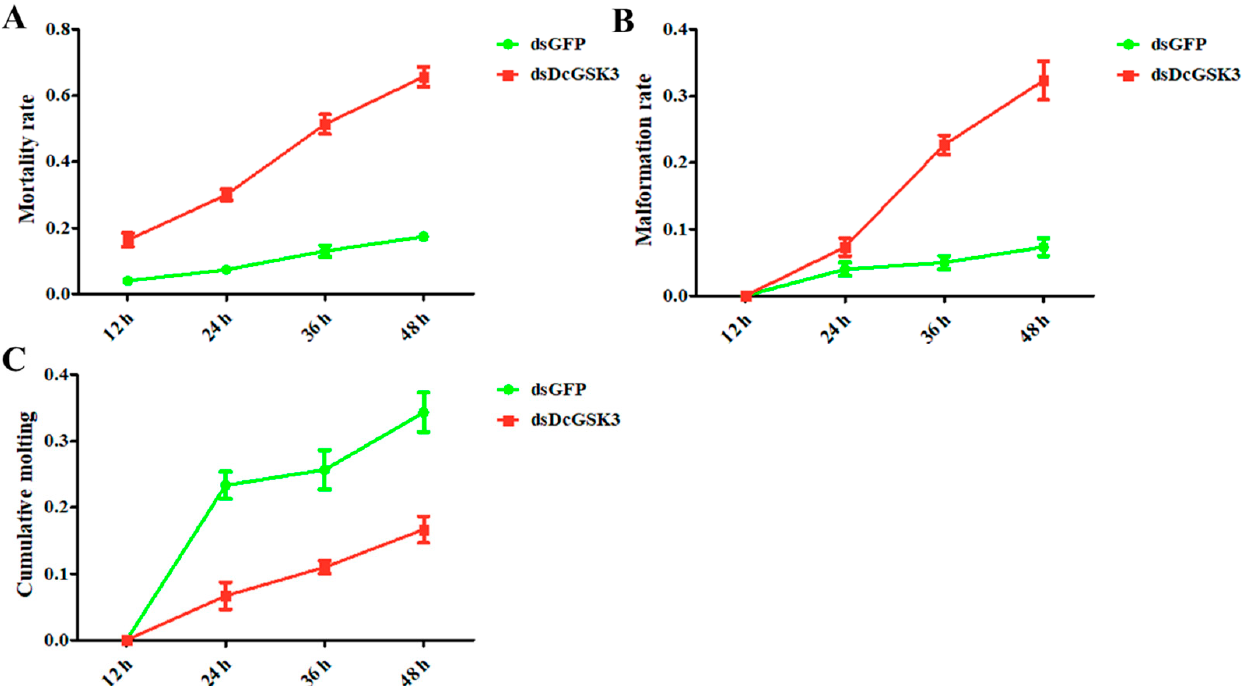
Figure 5. Effect of DcGSK3 on the development of D. citri from 12 h to 48 h. ( A ) Detection of mortality after inhibition of DcGSK3 . The ds GFP treatment group was used as a control; ( B ) detection of malformation rate after inhibition of DcGSK3 ; ( C ) detection of cumulative molting of D. citri after inhibition of DcGSK3 .